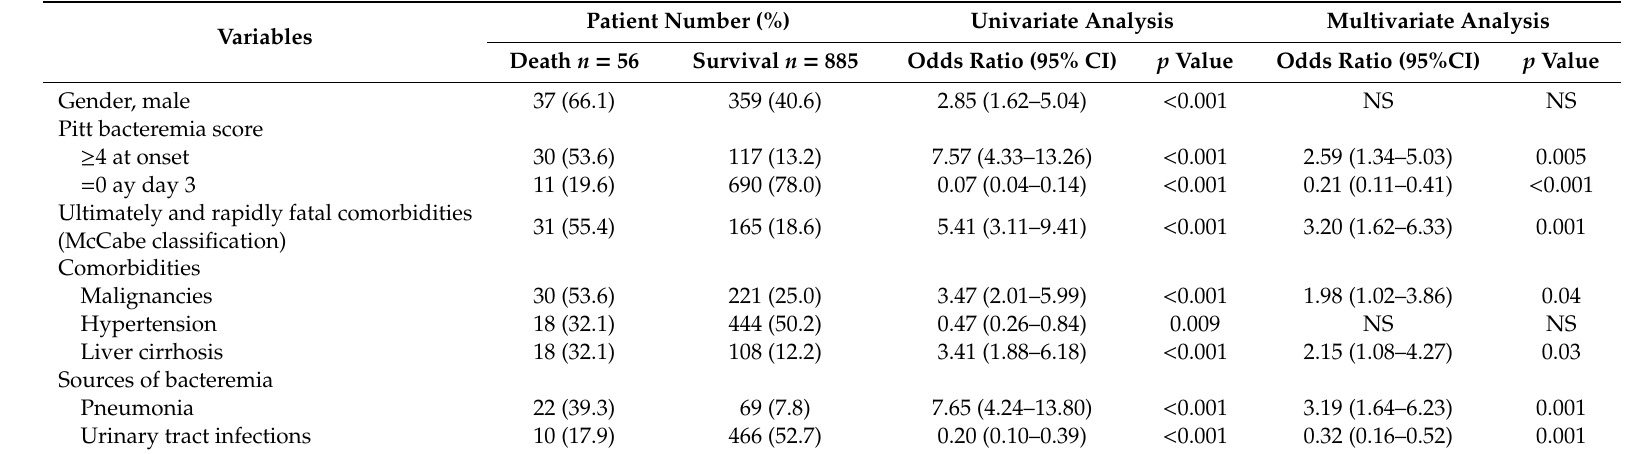
Table 2. Risk factors of 30-day crude mortality in the overall